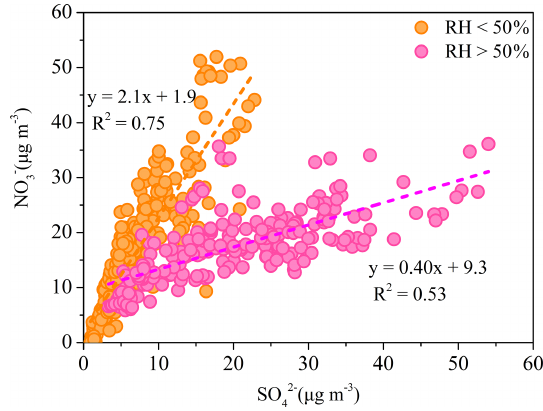
and NO − during low-RH 4 3